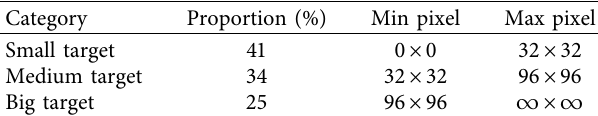
Table 3: COCO-2014